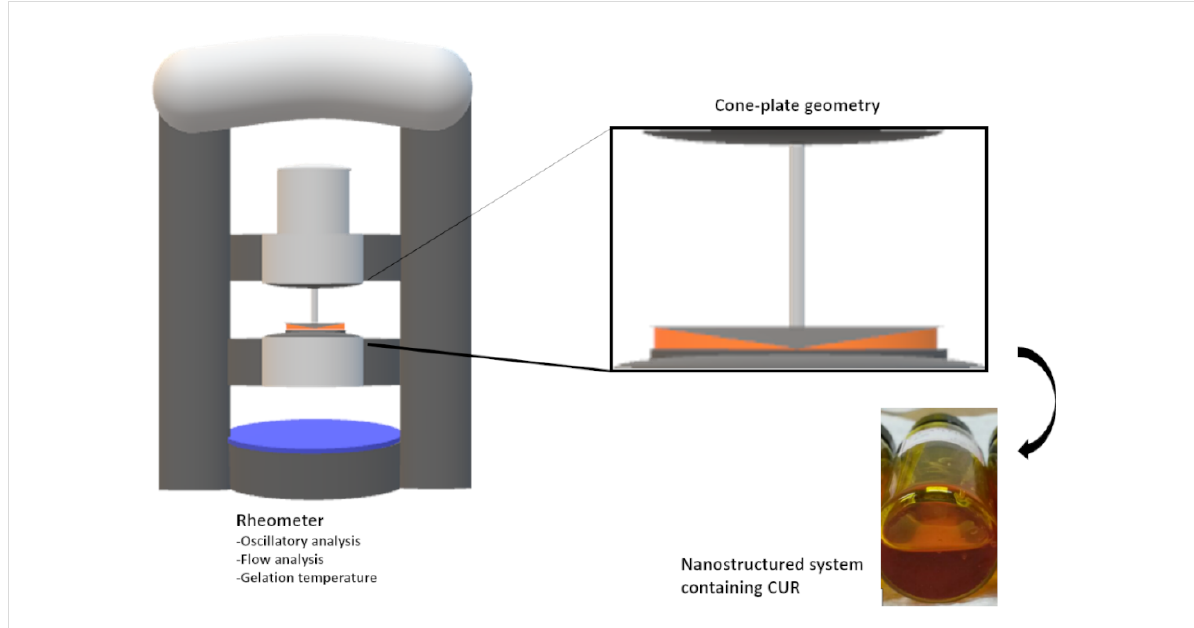
Figure 13: Schematic presentation of the rheological analysis setup utilized for continuous shear (flow) and oscillatory rheometry analysis of the formulations.